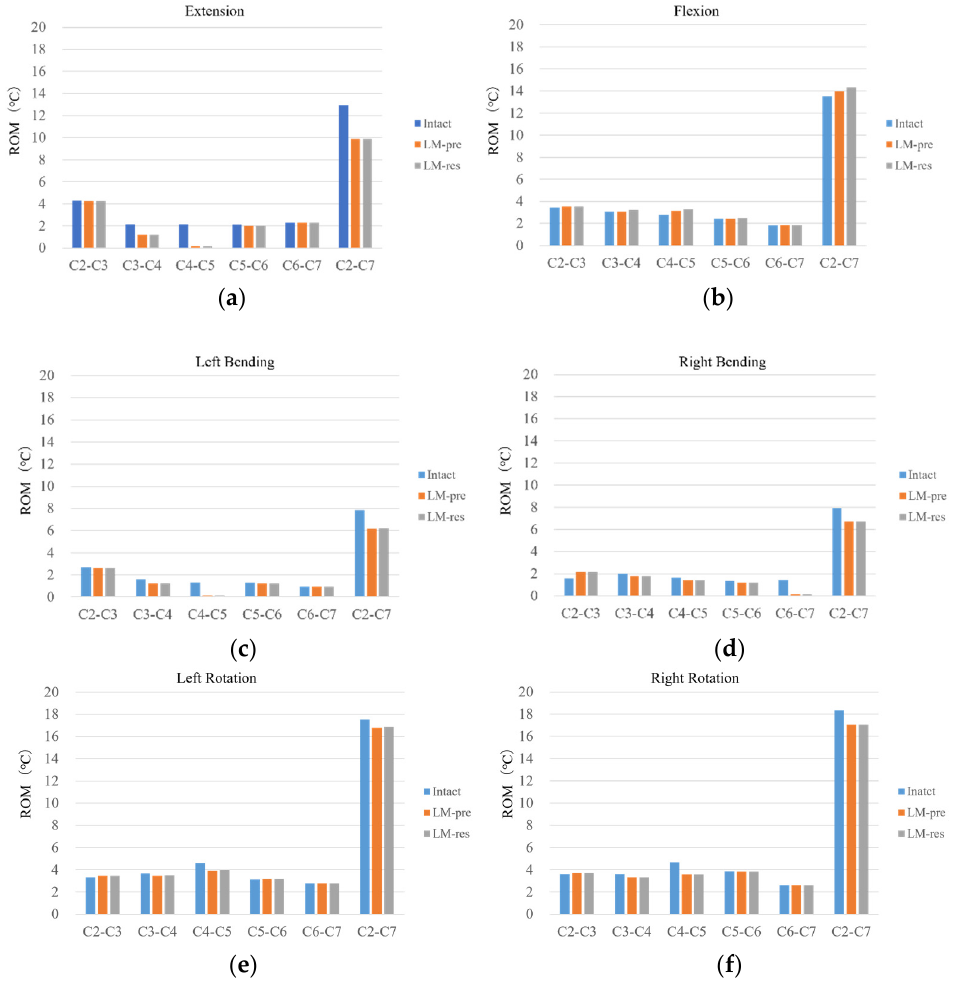
Figure 6. Range of motion. ( a ) Extension, ( b ) flexion, ( c ) left bending, ( d ) right bending, ( e ) left rotation, and ( f ) right rotation. The vertical axis is an angle (degree), the horizontal axis is each intervertebral level.